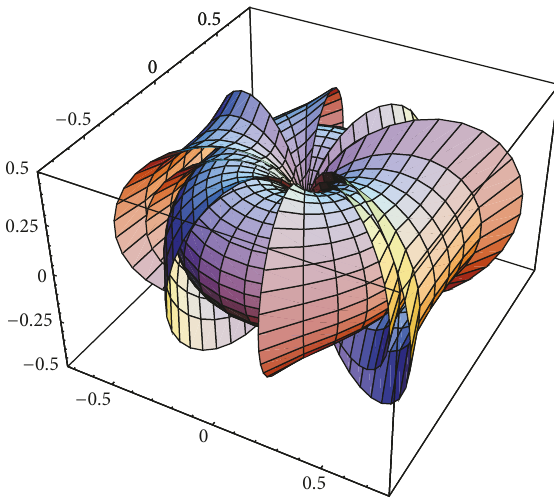
Figure 4: The linear solutions |Ψ| 2 = 0.5 , 0.6 , 0.75 , and 0.9 isoplot surfaces for 𝜒 = 0.5 , 𝑎 ∞ = 10 , 𝐿 = 1 , calculated with the quasi- polynomial solutions Eq. (42) for 𝐸 = −5.3 . The surfaces are tori- like, as expected from the behavior of 𝑎 = const. surface coordinates, Figure 11. Some of the exterior surfaces are plotted only partially, in order to make visible the torus shape of the inner